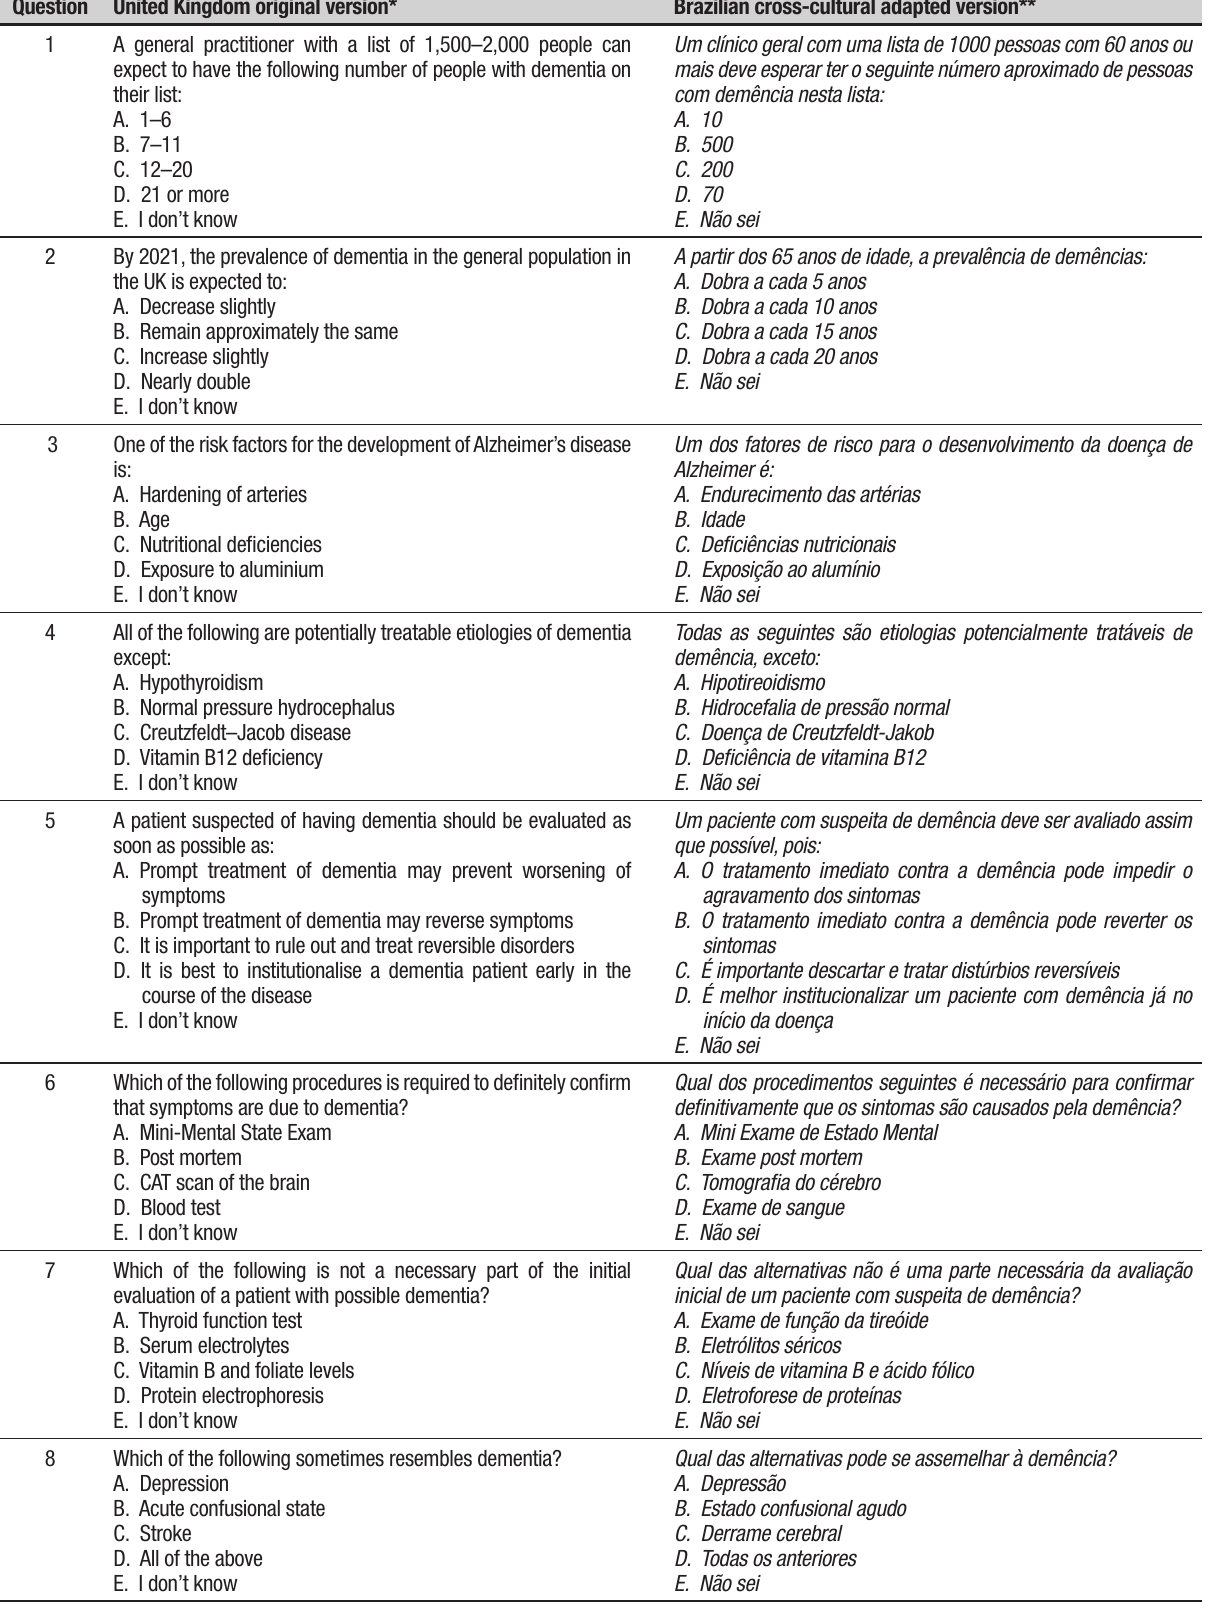
Table 1. The Knowledge Quiz about dementia in its United Kingdom original version 10 and Brazilian cross-cultural adapted version. Question United Kingdom original version* Brazilian cross-cultural adapted version**